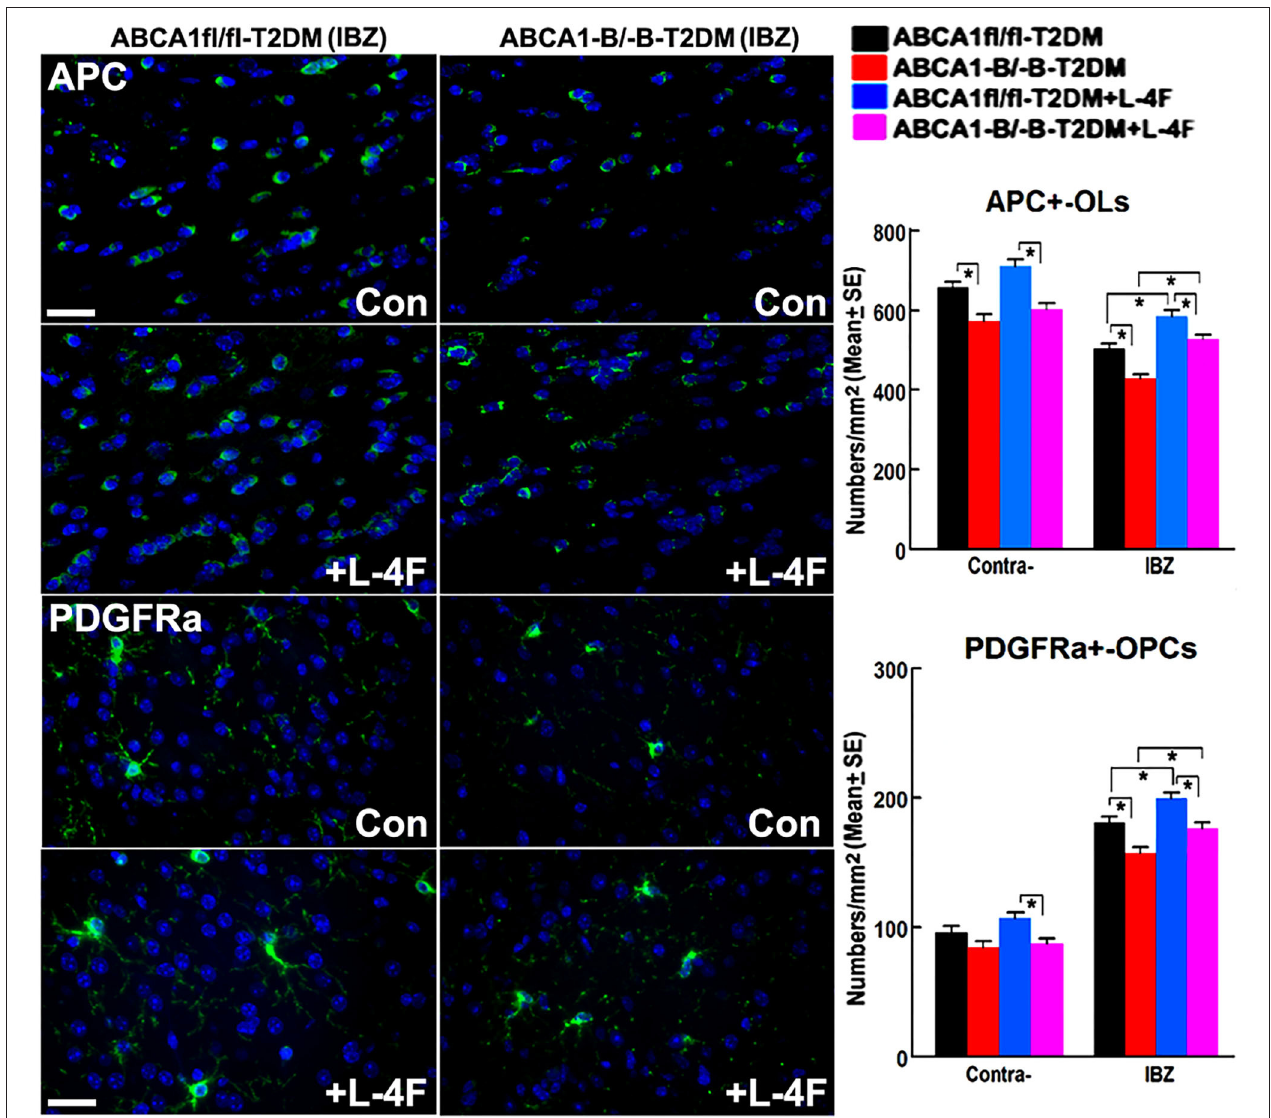
ABCA1 fl / fl -T2DM and ABCA − B / − B -T2DM stroke mice